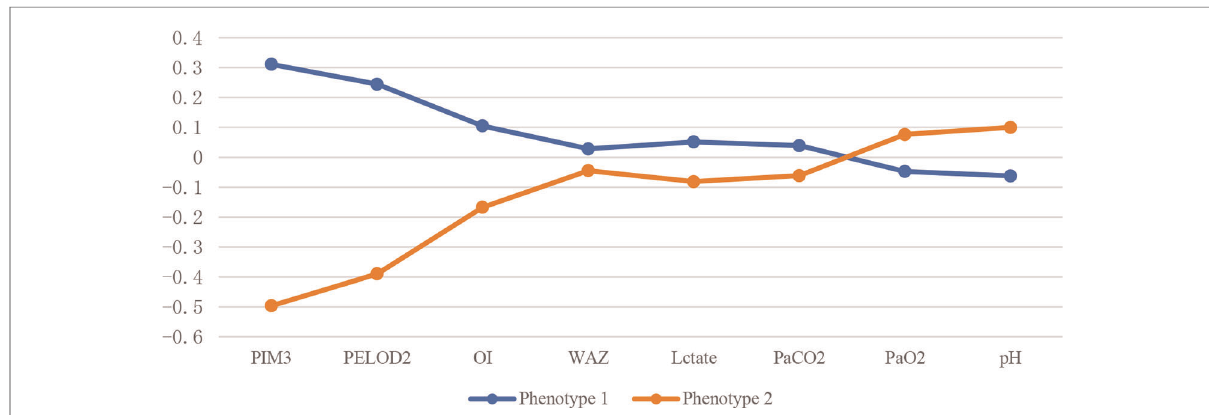
FIGURE 3 Continuous variables of different subphenotypes. PELOD2, Pediatric Logistic Organ Dysfunction 2 score; PIM3, Pediatric Index of Mortality 3 score; OI, oxygenation Index; WAZ, weight-for-age z-score.